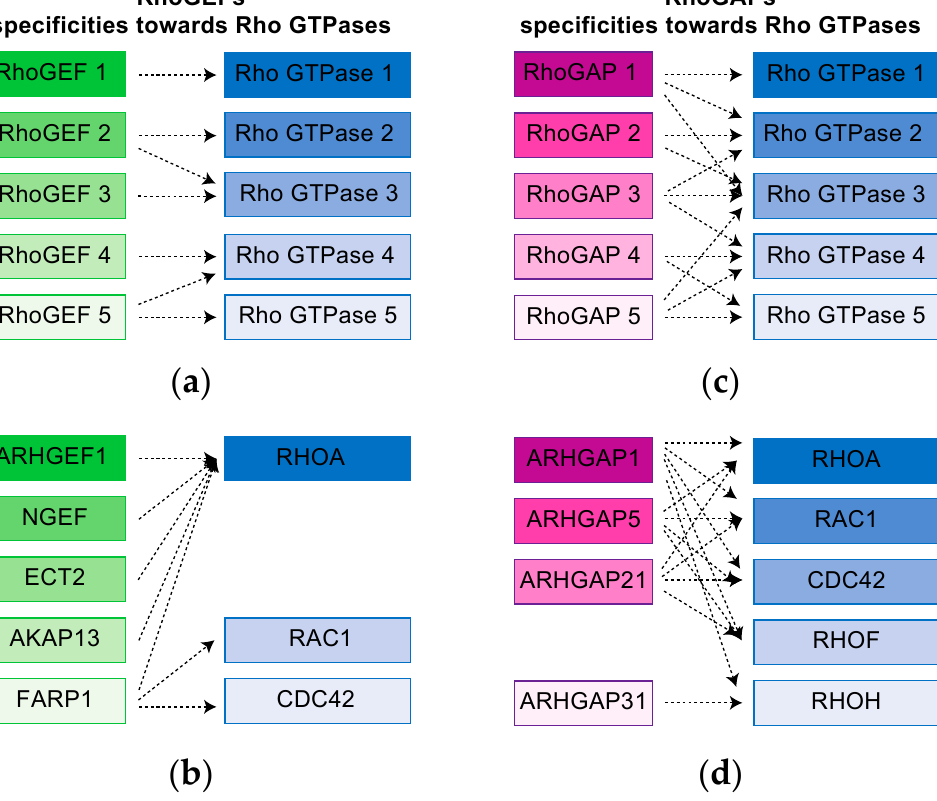
Figure 3. Mapping of Rho GTPases regulators specificities. ( a ) RhoGEFs exhibit specificity towards few Rho GTPases. ( b ) Examples of RhoGEFs and their specificity towards Rho GTPases as mapped by proximity labeling coupled with mass spectrometry. ( c ) RhoGAPs are promiscuous and display broad activity towards Rho GTPases. ( d ) Examples of Rho GAPs and their specificity towards Rho GTPases as mapped by proximity labeling coupled with mass spectrometry.